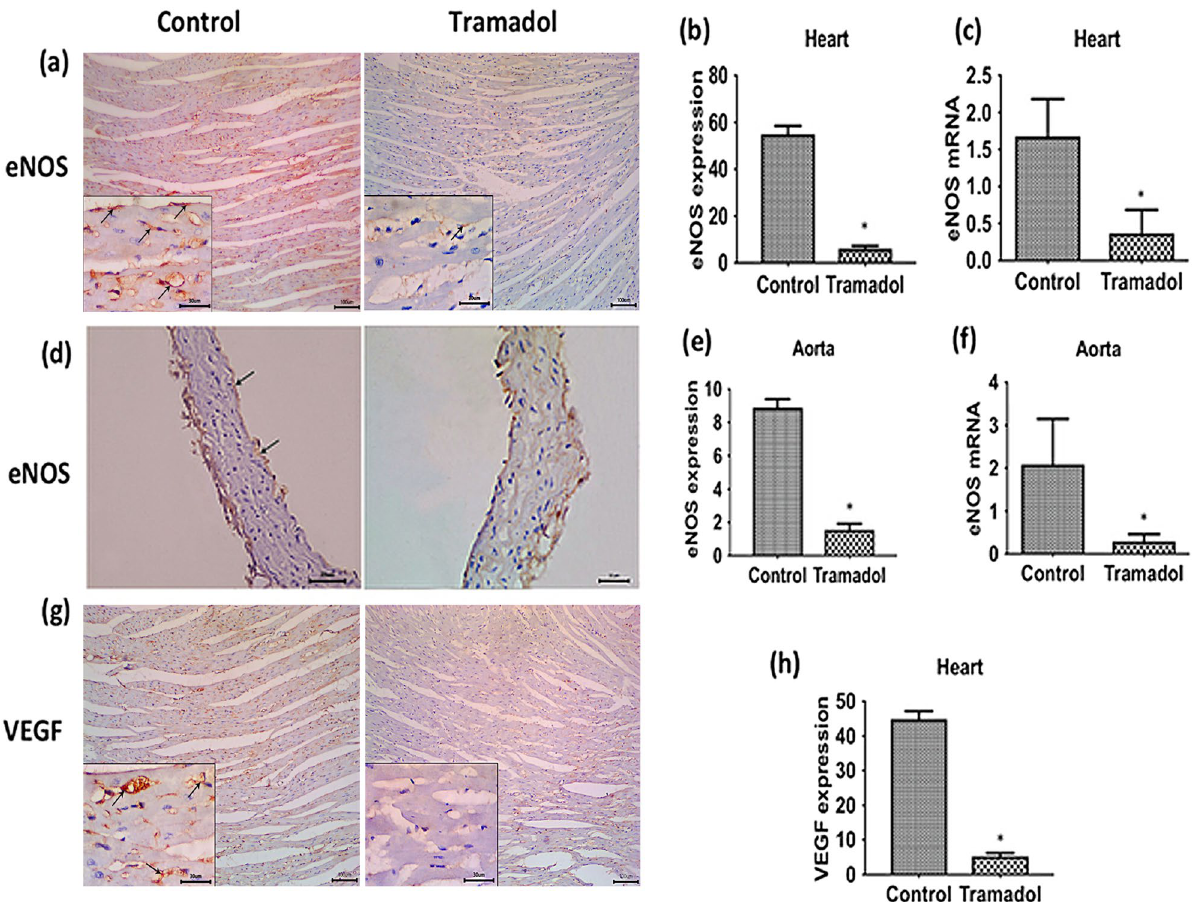
Figure 7. ( a ), ( d ) Immunohistochemistry staining images showing expression of eNOS in cardiac muscle ×100 (inset: ×400) and thoracic aorta ×400 respectively of control and tramadol treated mice. Arrows show the specific staining for the antibody. ( b ), ( e ) Relative quantification of immunohistochemistry staining for eNOS in cardiac muscle and thoracic aorta, respectively of both groups, n = 10. Data are expressed as means ± SEM, *p < 0.05 for control versus tramadol. ( c ), ( f ) Relative quantitative expression of mRNA levels of eNOS in cardiac muscle and thoracic aorta respectively of control and tramadol treated mice. All gene expression levels were normalized to GAPDH, n = 10. Data are expressed as means ± SEM, *p < 0.05 for control versus tramadol. ( g ) Immunohistochemistry staining images ×100 (inset: ×400) showing VEGF expression in cardiac muscle of control and tramadol treated mice. Arrows show the specific staining for the antibody. ( h ) Relative quantification of immunohistochemistry staining for VEGF in cardiac muscle of control and tramadol treated mice, n = 10. Data are expressed as means ± SEM, *p < 0.05 for control versus